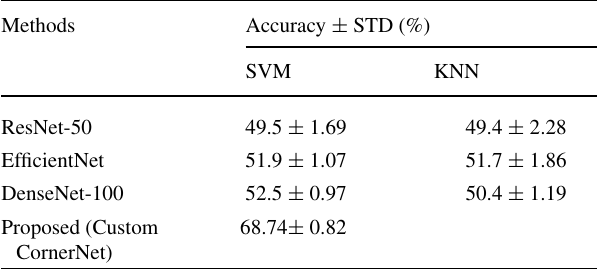
Table 6 Performance comparison of the proposed approach with ML- based classifiers